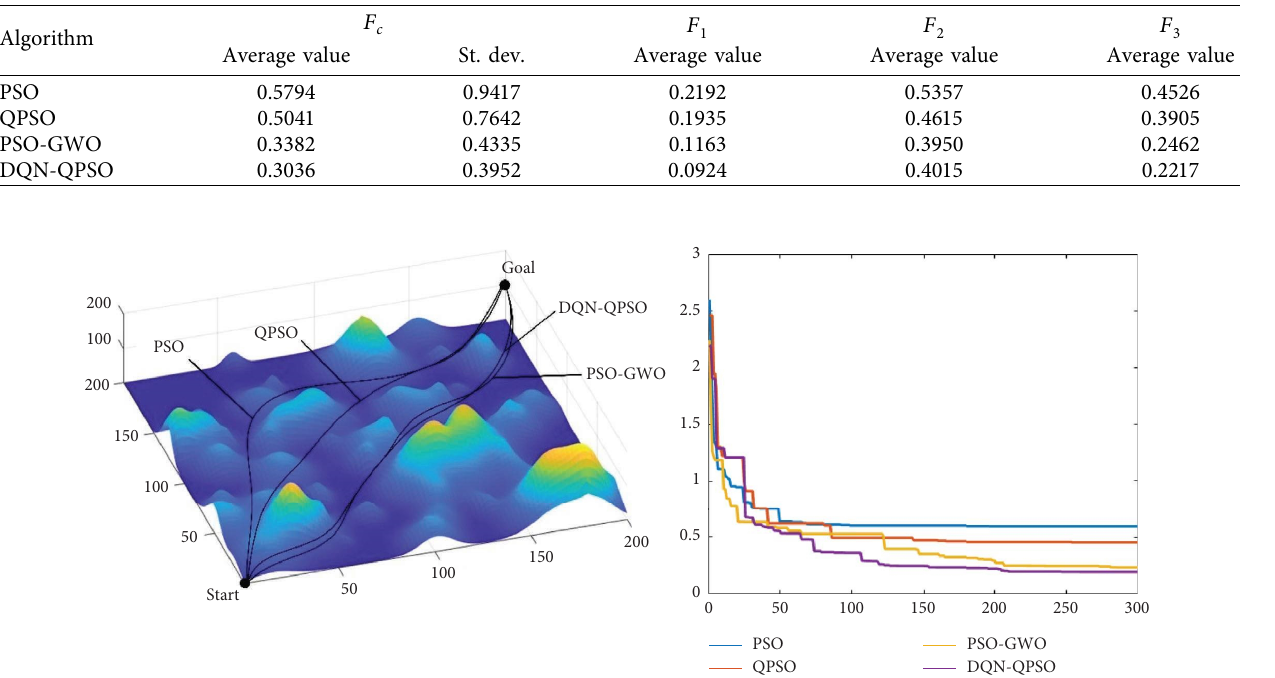
Figure 6: Path planning diagram in the sea current environment. Table 2: Comparison of the results of the two algorithms.